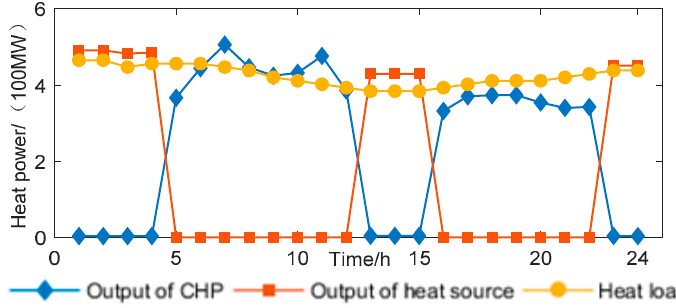
Figure 6. Heating network optimized operation data.